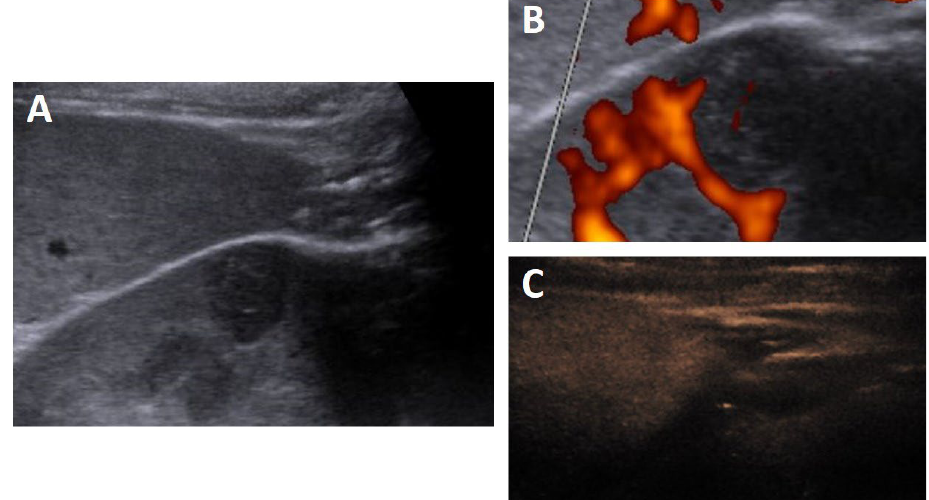
Figure 2. Ultrasonography demonstrates a hypoechoic lesion with small linear slight hyperechoic lines ( A ) without significant blood flow in color flow Doppler ( B ) but with a slight contrast enhance- ment in the late phase of contrast-enhanced ultrasound (CEUS) ( C ).